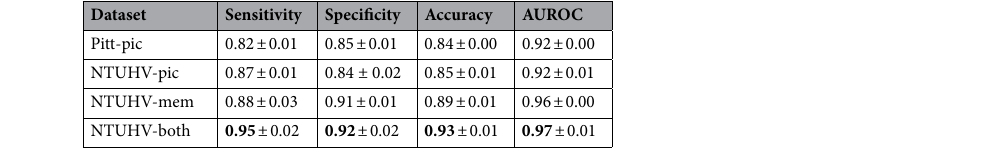
Table 5. Performance of AD vs. HC on different datasets. Bold is used to highlight the highest value in each